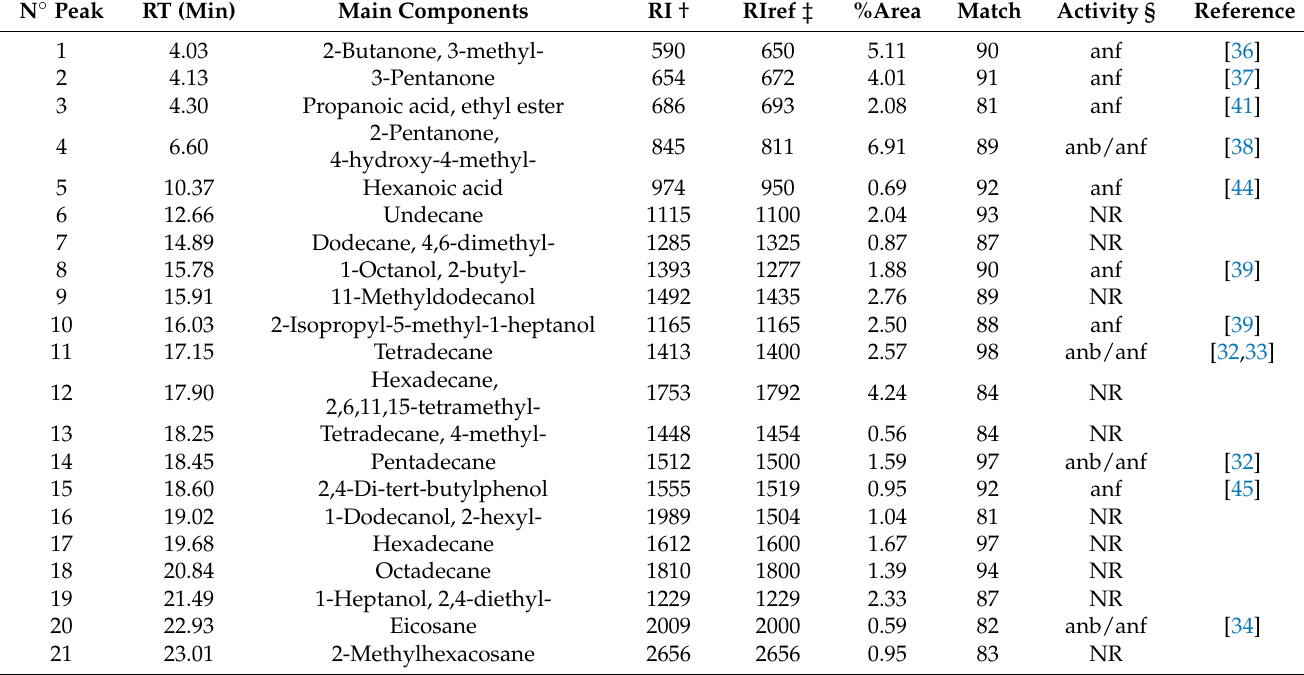
Table 1. Compounds identified by GC-MS from the hexane extract of H. osmophila